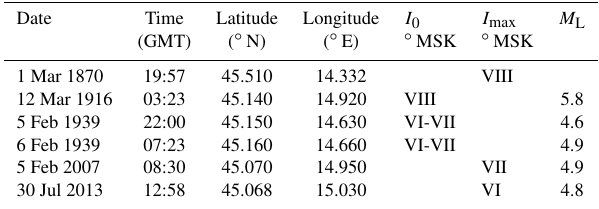
Table 4. Basic parameters for the set of earthquakes that were mi- croseismically